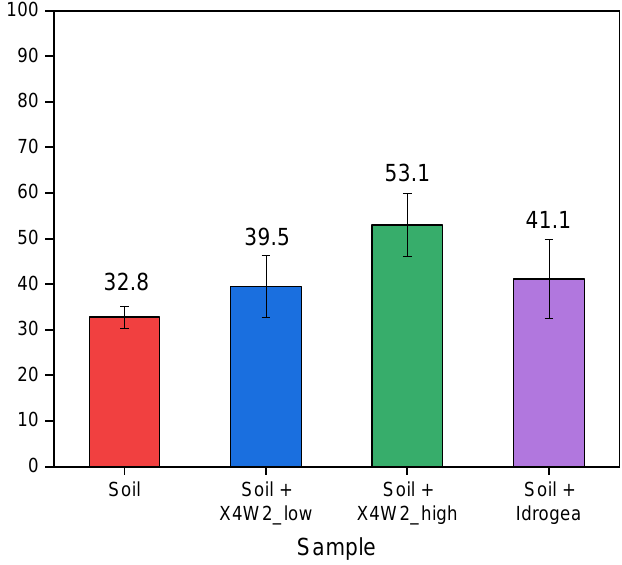
Figure 7. Maximum water holding capacity of soil with X4W2 samples ( low and high ) and Idrogea.